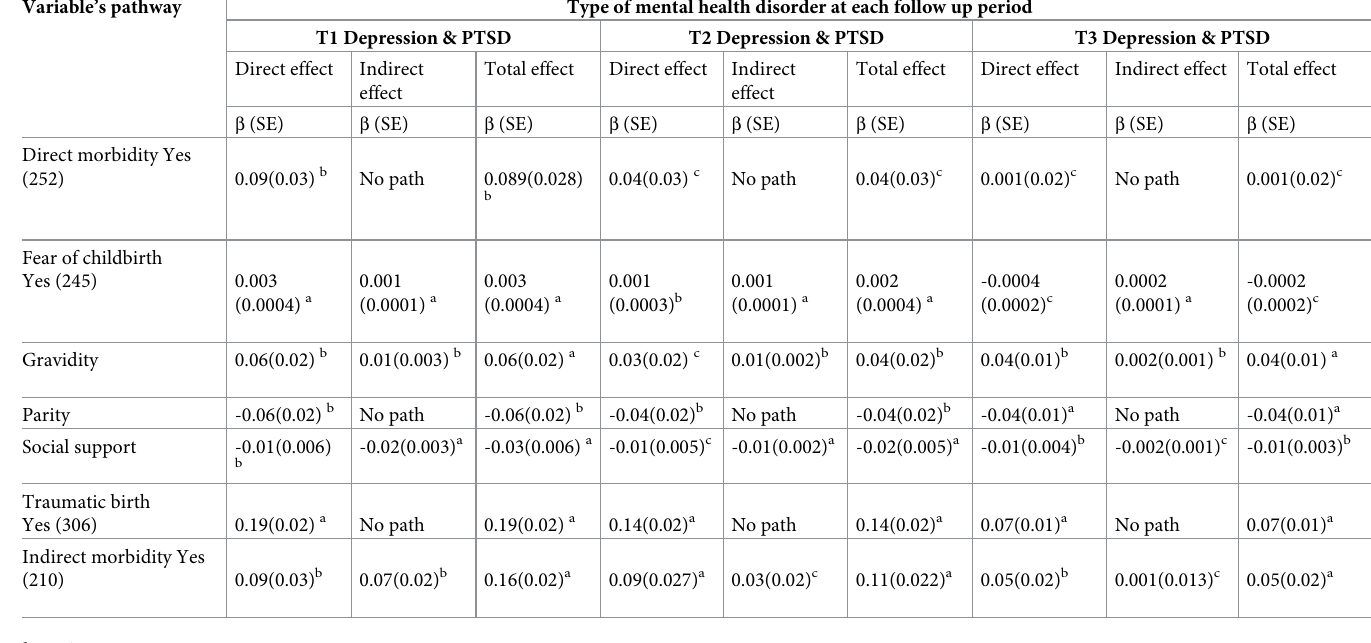
Table 7. Direct, Indirect and total effects of variables associated with comorbidity of depression and PTSD, among postpartum women in Northwest Ethiopia,